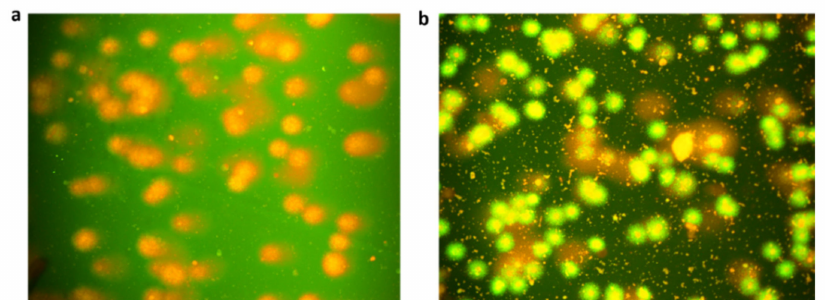
Figure 7. ( a ) Doxorubicin as positive control, ( b ) MgO-NPs against cell